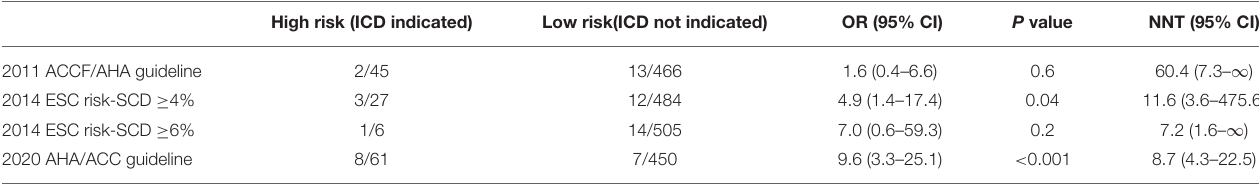
TABLE 2 | Comparison of the odds ratio and number needed to treat for event predicting models. High risk (ICD